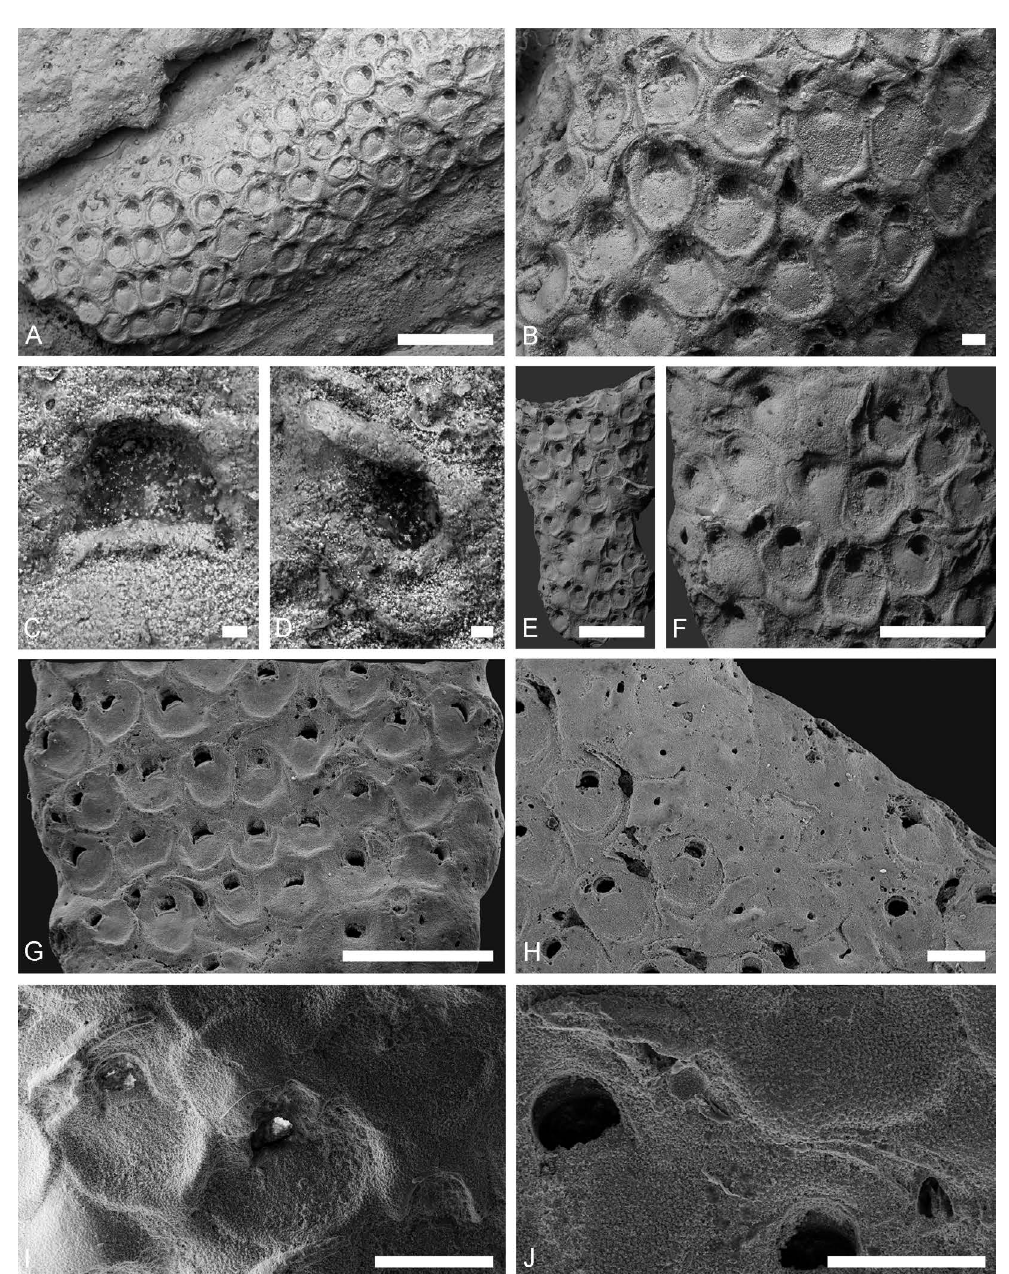
Fig. 14. Rhagasostoma gibbosulum Brydone, 1936. A–D . Holotype, SM B36887, middle Campanian ( Belemnitella mucronata Zone) of Isle of Wight, High Down, England, UK. A . Overview of erect bifoliate colony. B . Non-ovicellate autozooids and avicularia. C . Opesia of autozooid. D . Avicularium. E–F . PIN 2922/242, erratic block of ?late Campanian age, quarry near Hrodna/Grodno (Гродна/ Гродно), Grodno Region, Belarus. E . Overview of erect bifoliate colony. F . Non-ovicellate autozooids and avicularia. G–J . Early Maastrichtian, Saturn quarry near Kronsmoor, Schleswig-Holstein, Germany. G . SMF 29908, overview of part of erect bifoliate colony. H . SMF 29909, autozooids, avicularia and kenozooids. I . SMF 29911, non-ovicellate autozooid with long gymnocyst(?), two ovicellate autozooids (with non-damaged ooecium to the right), and avicularium with wedge-like growth. J . SMF 29912, non-ovicellate autozooids and avicularia, one from which with wedge-like growth. Scale bars: A, E, G = 1 mm; B = 100 µm; C–D = 20 µm; F = 500 µm, H–J = 300